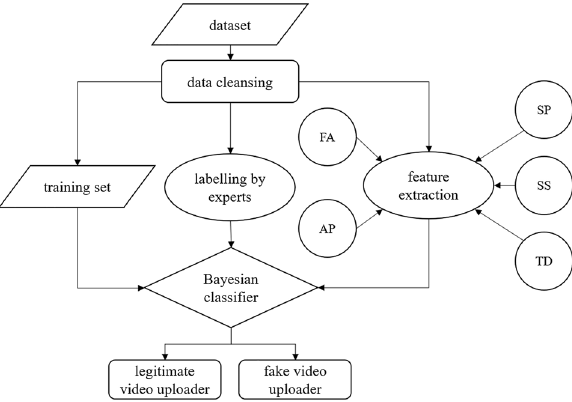
Figure 1. Workflow for detection of fake-video